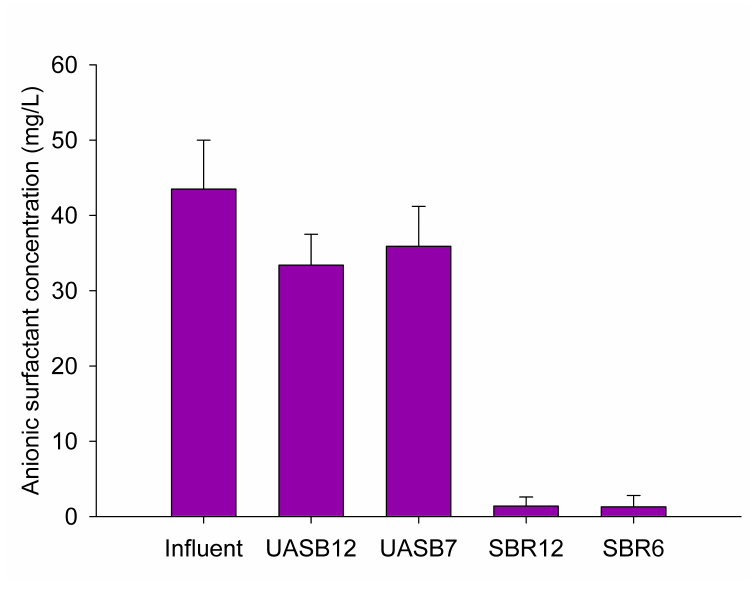
Influent and effluent concentrations of anionic surfactants in 4 bioreactors treating